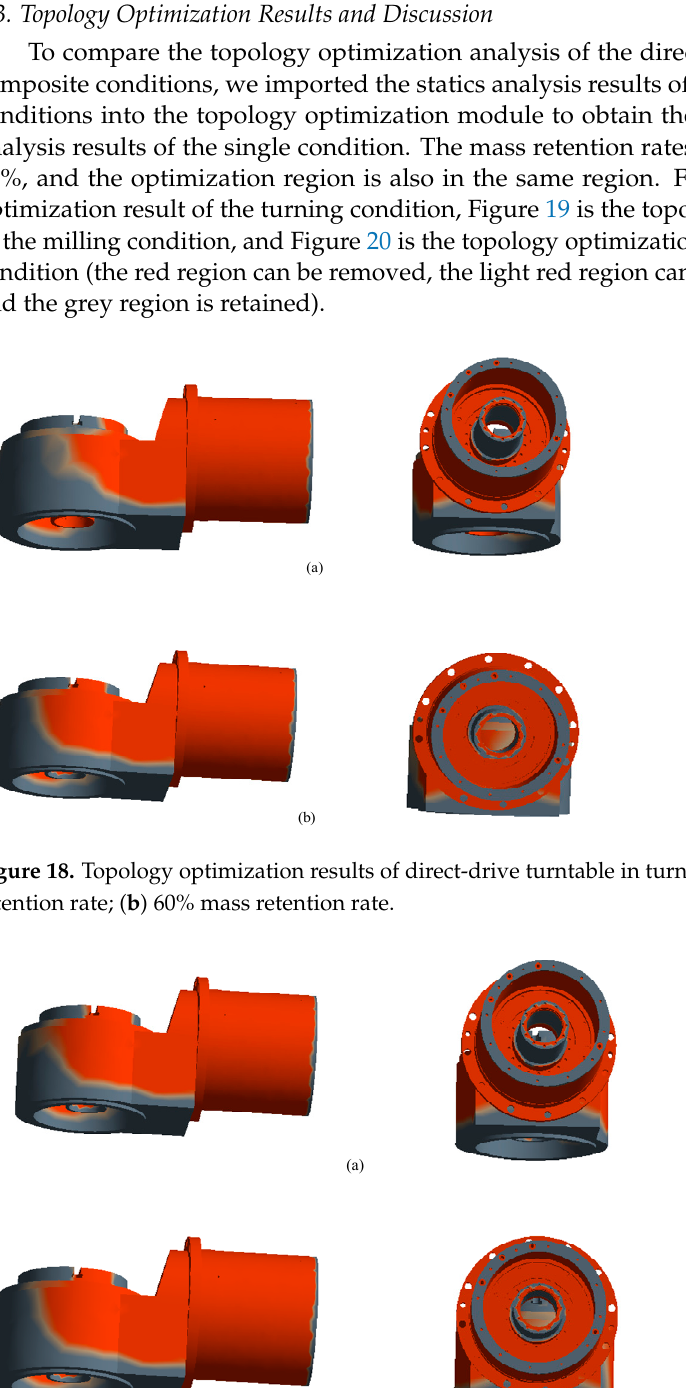
Figure 20. Topology optimization results of direct-drive turntable in composite condition: ( a ) 50% mass retention rate; ( b ) 60% mass retention rate.